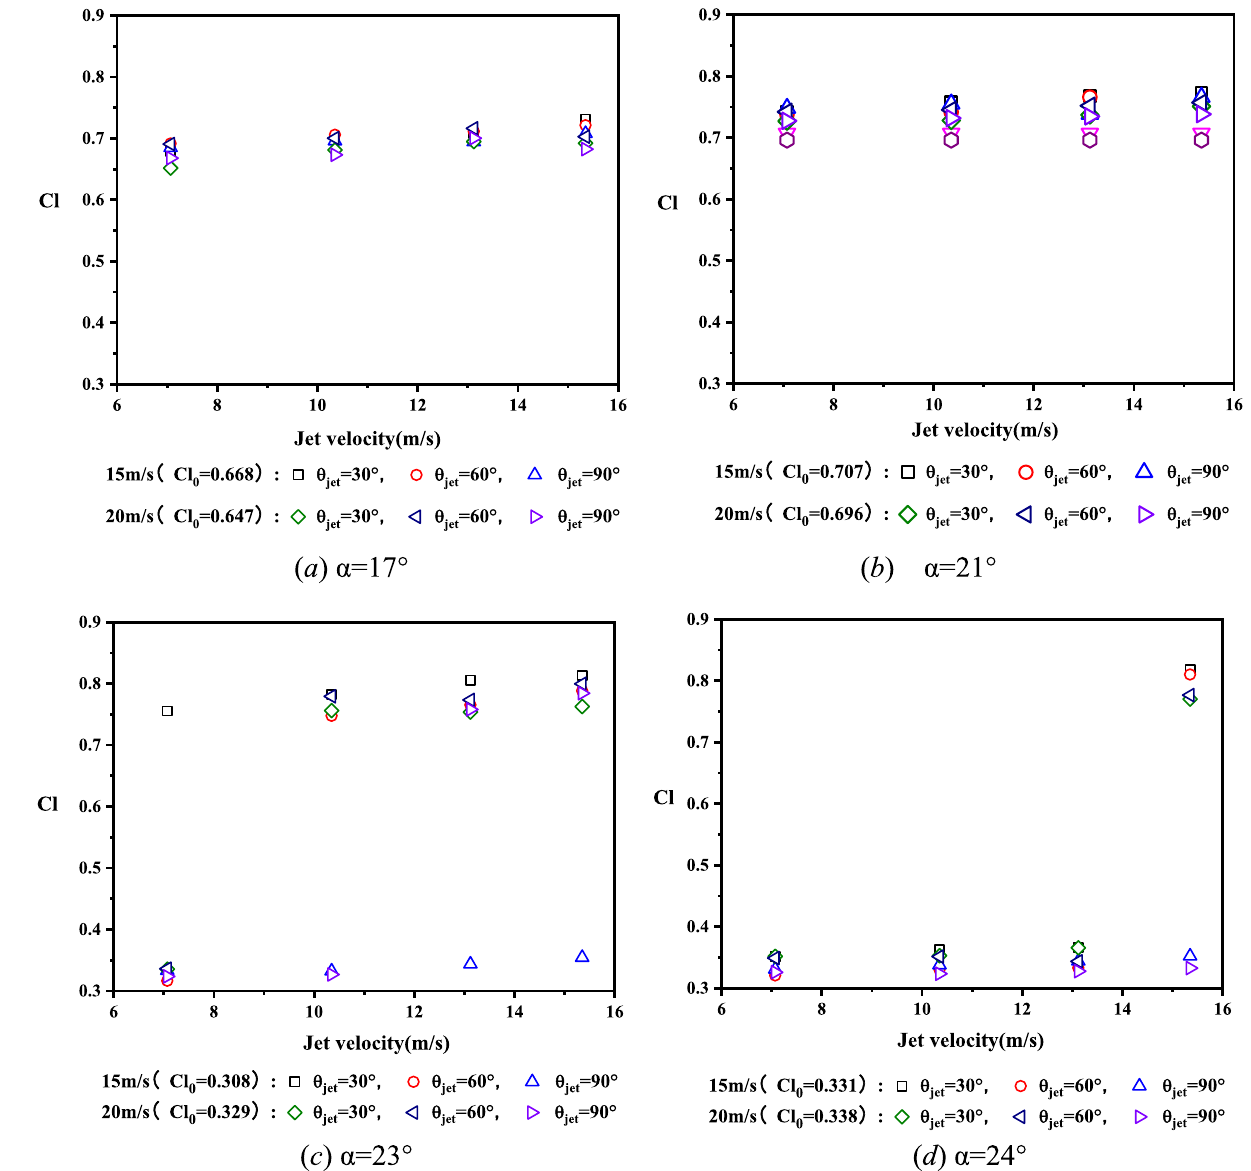
Figure 15. Lift coefficients of airfoil with and without jet control at different